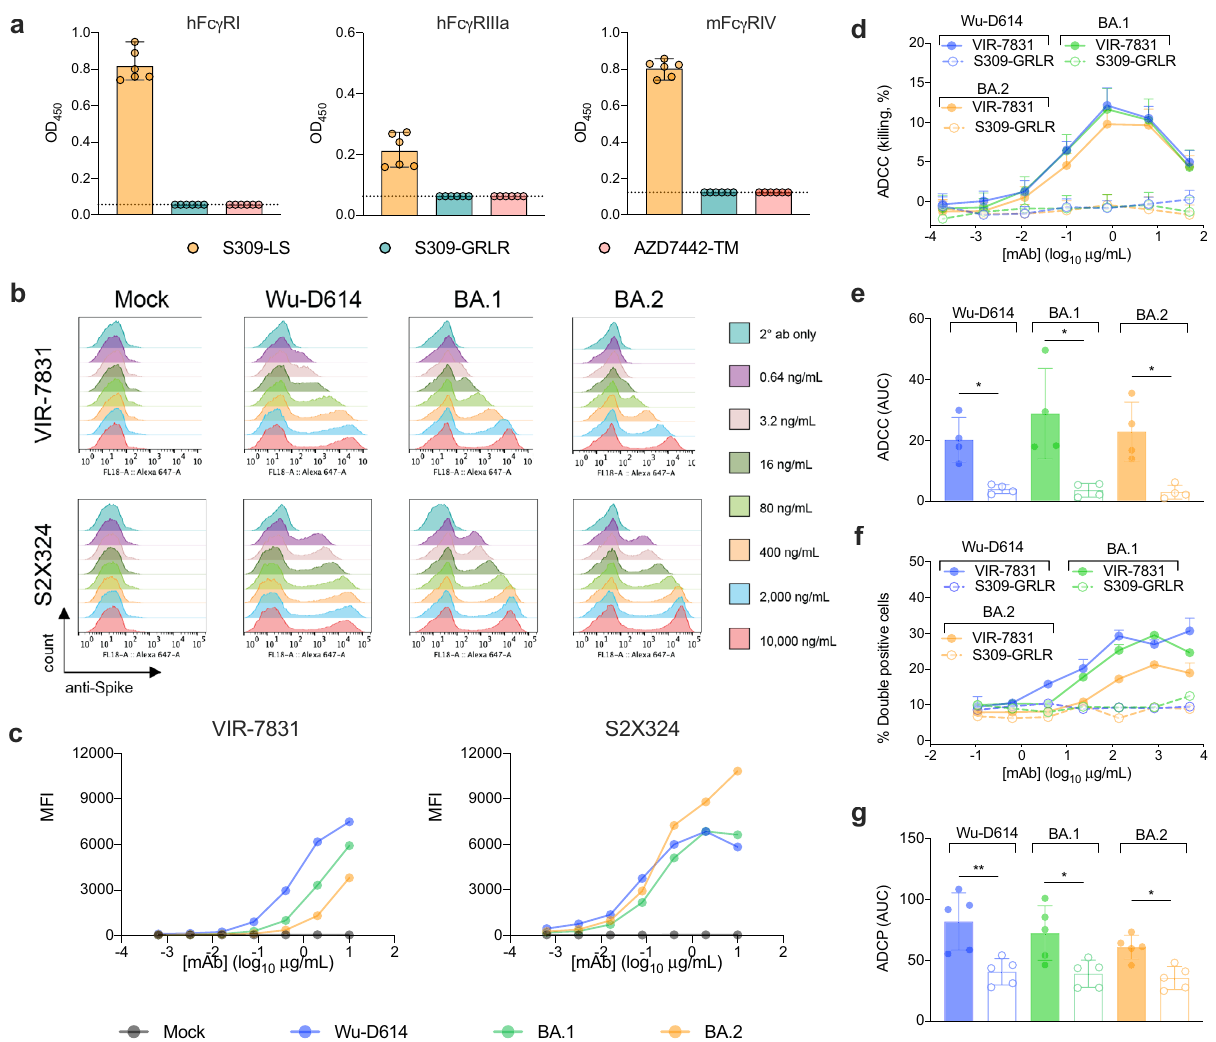
Fig. 3 VIR-7831 binds and instructs effector cells for ADCC and ADCP. a Binding of S309-LS, S309-GRLR, or AZD7442-TM mAbs to hFc γ RI, hFc γ RIIIa, or mFc γ RIV (two experiments; dotted lines indicate the limit of detection; data are presented as meanvalues ± range). b ExpiCHO-S cells were transiently transfected with plasmids encoding the indicated SARS-CoV-2 spike protein. 24 to 48 h later, cells were harvested, washed, and stained with the indicated concentrations of VIR-7831 or S2X324 mAbs to assess binding to the cell surface. Representative histograms from two or three experiments are shown. c Antibody binding curves for VIR-7831 and S2X324 using the data in b and presented as mean fl uorescence intensity (MFI) versus antibody concentration. d , e ExpiCHO-S cells transiently transfected with Wuhan-1 D614, BA.1, or BA.2 spike proteins were incubated with the indicated concentrations of VIR-7831 or S309-GRLR mAb and mixed with puri fi ed NK cells isolated from healthy donors at a ratio of 1:9 (target:effector). Cell lysis was determined by a lactate dehydrogenase release assay. Data are presented as mean values ± standard deviations (SD) from one representative of four donors ( d ). Area under the curve (AUC) analyses from four NK donors ( e ) (see Supplementary Fig. 8). f , g ExpiCHO-S cells transiently transfected with Wuhan-1 D614, BA.1, or BA.2 spike proteins and fl uorescently labelled with PKH67 were incubated with the indicated concentrations of VIR-7831 or S309-GRLR mAb and mixed with PBMCs labelled with CellTrace Violet from healthy donors at a ratio of 1:20 (target:PBMCs). Association of CD14 + monocytes with spike-expressing target cells (ADCP) was determined by fl ow cytometry. Data are presented as mean values ± SD from one representative of fi ve donors ( f ). AUC analyses of VIR-7831 and S309-GRLR for each Omicron variant for fi ve donors ( g ). e , g Two-tailed Mann-Whitney test between VIR-7831 and S309-GRLR for the indicated variant; * P < 0.05, ** P < 0.01. Source data are provided as a Source Data fi le. Gating strategies are shown in Supplementary Fig. 8c. Methods generated in Vero-TMPRSS2 cells and subjected to next-generation sequencing as Cells . Vero-TMPRSS2 38 and Vero-hACE2-TMPRRS2 39 cells were cultured at described previously 39 to con fi rm the presence and stability of expected substitu- tions (see Supplementary Table 2). All virus experiments were performed in an 37°C in Dulbecco ’ s Modi fi ed Eagle medium (DMEM) supplemented with 10% approved biosafety level 3 (BSL-3) facility. fetal bovine serum (FBS), 10 mM HEPES pH 7.3, 1mM sodium pyruvate, 1× non- essential amino acids, and 100 U/ml of penicillin – streptomycin. Vero-TMPRSS2 cells were supplemented with 5 μ g/mL of blasticidin. Vero-hACE2-TMPRSS2 cells Monoclonal antibody puri fi cation . The mAbs studied in this paper, S309, were supplemented with 10µg/mL of puromycin. ExpiCHO-S cells were obtained AZD8895, AZD1061, and the AZD7442 cocktail have been described from Thermo Fisher Scienti fi c. All cells routinely tested negative for mycoplasma previously 9,18,20 . using a PCR-based assay. S309-LS and S309-GRLR were produced in ExpiCHO-S cells and af fi nity- puri fi ed using HiTrap Protein A columns (GE Healthcare, HiTrap mAb select Xtra Viruses . The Beta (B.1.351) and Omicron (BA.1 (R346), BA.1.1 (R346K), and #28-4082-61) followed by buffer exchange to histidine buffer (20 mM histidine, 8% BA.2) strains were obtained from nasopharyngeal isolates. All virus stocks were sucrose, pH 6.0) using HiPrep 26/10 desalting columns. The fi nal products were NATURE COMMUNICATIONS| (2022) 13:3824